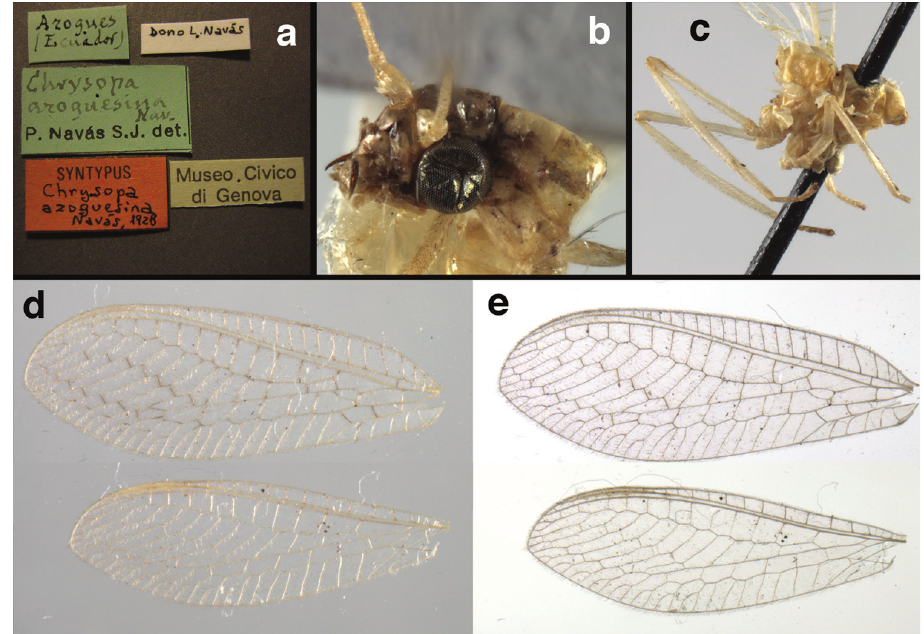
Figure 52. Chrysopa aroguesina Navás: External features, ( a ) labels ( b ) head (damaged), dorsolateral ( c ) thorax (damaged), dorsolateral ( d ) wings showing markings on veins ( e ) wings showing venation (Ecuador, Azogues, paralectotype,